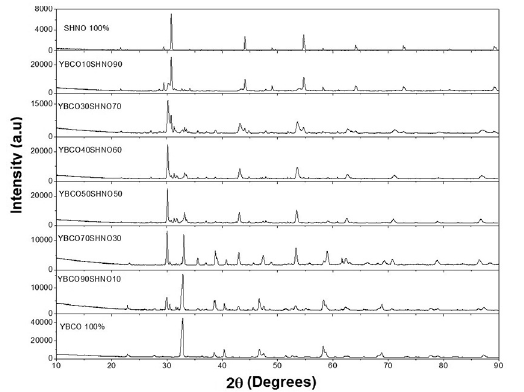
Figure 4: XRD pattern for 0 to 100 mass% of SHNO in an YBCO